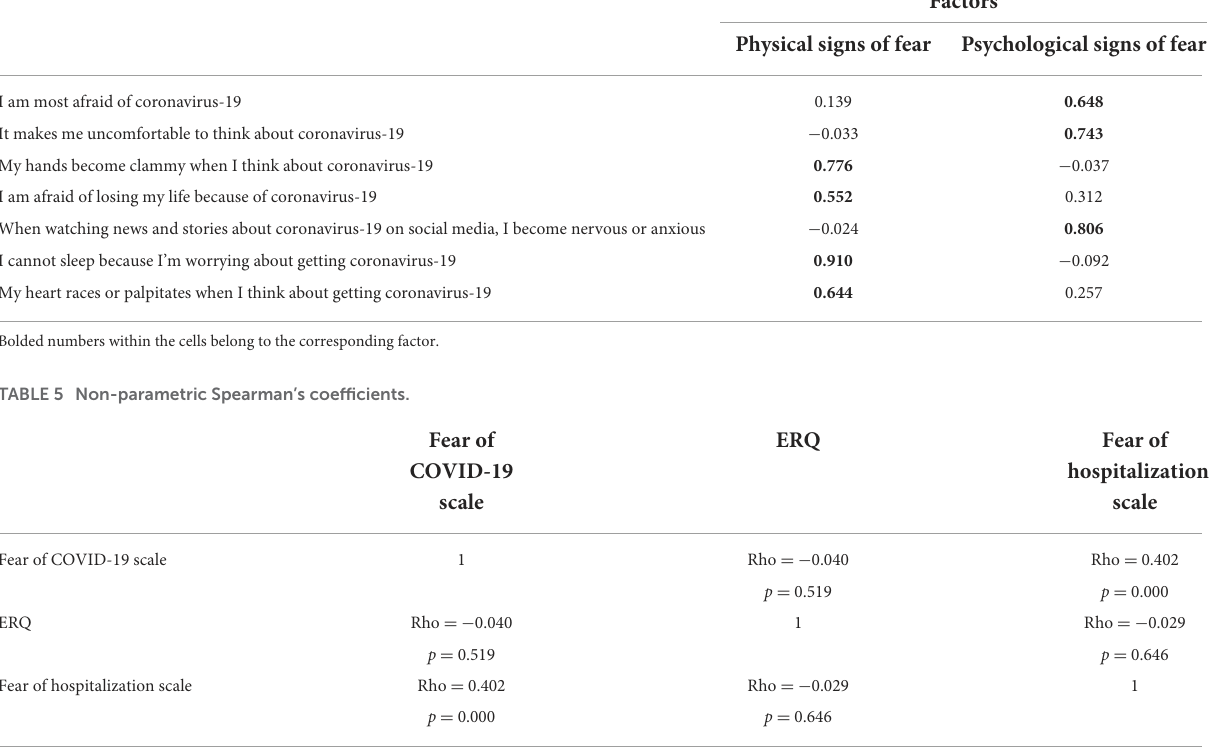
TABLE 4 The rotated component matrix of the Fear of COVID-19 scale with factor loading per each item.